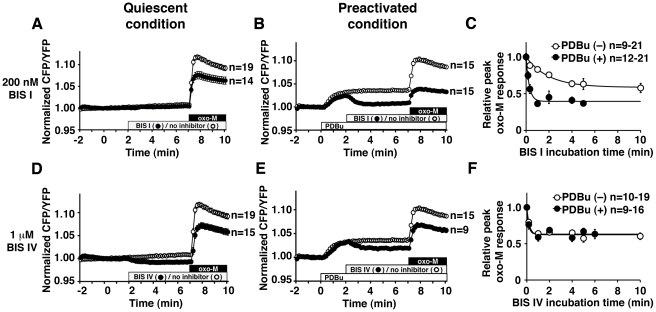
Activation status of PKC changes the inhibition kinetics of BIS I but not BIS IV.(A) Oxo-M responses with (closed circles) or without (open circles) BIS I in the quiescent condition. The boxes indicate the presence of 200 nM BIS I (grey) and 3 µM oxo-M (black). (B) Oxo-M responses with (closed circles) or without (open circles) BIS I in the preactivated condition. Cells were treated sequentially with 100 nM phorbol 12,13-dibutyrate (PDBu) (open box), 200 nM BIS I (grey box), and 3 µM oxo-M (black box). (C) Relative peak oxo-M responses from experiments similar to (A) and (B) with various incubation times with BIS I. Peak oxo-M responses under various BIS I incubation times are normalized to the peak response without BIS I treatment (t = 0). For instance, (A) represents two data points for the PDBu(–) condition, t = 0 min (no inhibitor, n = 19) and t = 5 min (BIS I, n = 14). (B) represents two data points for the PDBu(+) condition, t = 0 (no inhibitor, n = 15) and t = 5 min (BIS I, n = 15). Preactivation with PDBu (closed circles) facilitates PKC inhibition by BIS I compared to no PDBu (open circles). (D) Oxo-M responses with (closed circles) or without (open circles) 1 µM BIS IV in the quiescent condition. The control is the same as in (A). (E) Oxo-M responses with (closed circles) or without (open circles) 1 µM BIS IV in the preactivated condition. The control is the same as in (B). (F) Time course of relative peak oxo-M responses showing inhibition kinetics of BIS IV for preactivated PKC (closed circles) and the control (open circles) from experiments similar to (D) and (E) with various incubation times with BIS IV. Relative peak oxo-M responses with various incubation time with BIS IV are calculated using response at t = 0 as a reference. Panel (D) represents two data points for the PDBu(–) condition, t = 0 (no inhibitor, n = 19) and t = 5 min (BIS IV, n = 15). Panel (E) represents two data points for the PDBu(+) condition, t = 0 (no inhibitor, n = 15), and t = 5 min (BIS IV, n = 9).